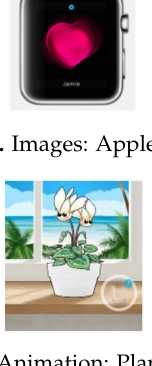
Figure 6. Animation: Plant